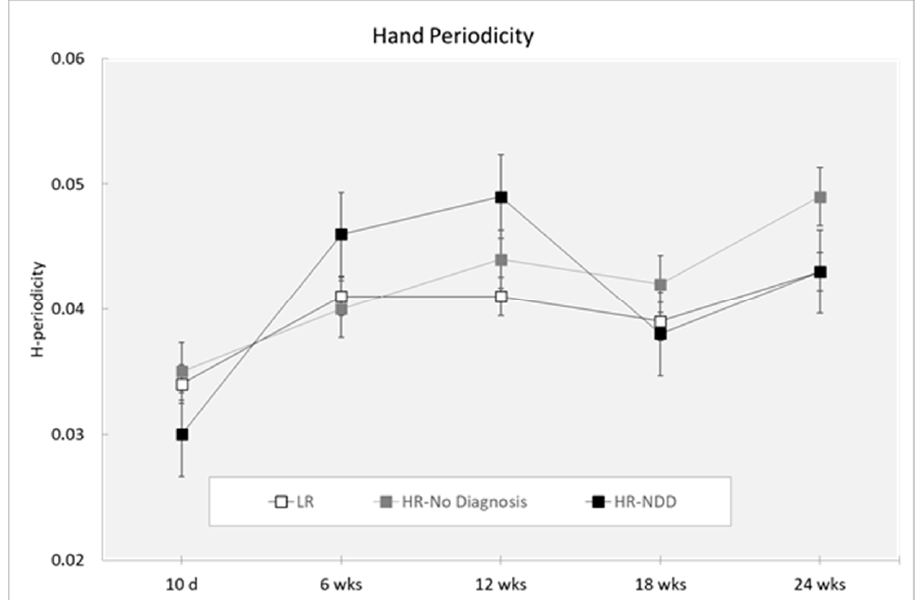
Figure 7. Hand periodicity in a 3-min session, measured at 10 days and 6, 12, 18, and 24 weeks in three groups of infants (LR, n = 53; HR-no diagnosis, n = 32; HR-NDD infants, n = 18). d = days; wks = weeks. Data are expressed as mean ± SEM. Periodicity is a nondimensional value.